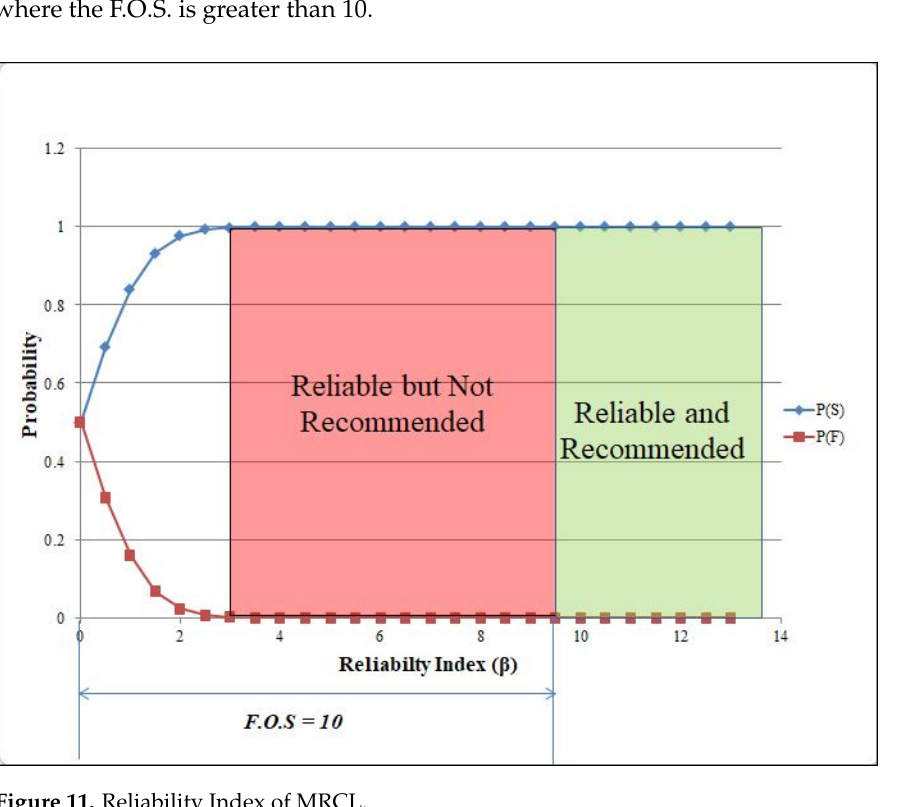
Figure 12. Simulation view of the steel wire rope. Figures 13 and 14 depict the equivalent stress and normal stress that resulted from applying the mathematically predicted required pulling force in phase I.